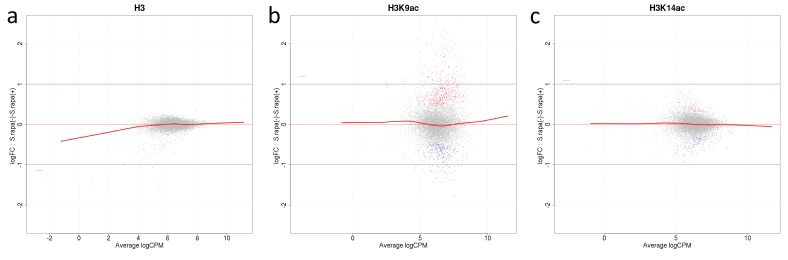
Mean average (MA) plots comparing normalized ChIP-seq LFCs H3(Cterm) (a), H3K14ac (b) and H3K9ac (c) of each gene between A. nidulans monoculture and co-culture for antibodies used in this study.The y-axis indicates LFCs of ChIP signal between mono- and co-culture for each gene which corresponds to the dots. The x-axis indicates mean intensity of ChIP signal of both conditions. Genes were colored according to DCS outcome with gray indicating genes with no significant change of ChIP signal, red and blue indicate genes showing respective higher or lower signal in co-culture.